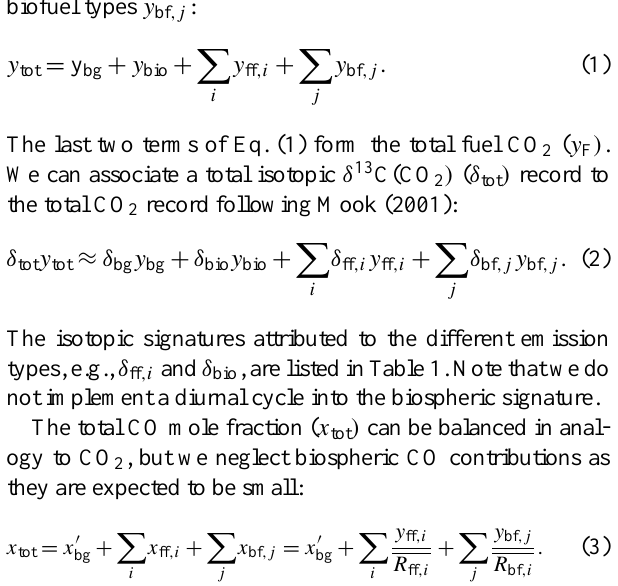
Table 1. δ 13 C(CO 2 ) source signature of fuel types and biosphere as used in the model. The isotopic signature of the biosphere follows the findings of Ballantyne et al. (2011) for Europe. The assigned isotopic fuel values were chosen from mean measured isotopic sig- natures in Heidelberg (Kaul, 2007, and unpublished data) or, if not available, are similar to isotopic δ 13 C(CO 2 ) values reported in An- dres et al. (1994) or (for biogas) Widory et al. (2012). Emission source δ ff ,i δ bf ,j or δ bio [‰] Hard coal Brown